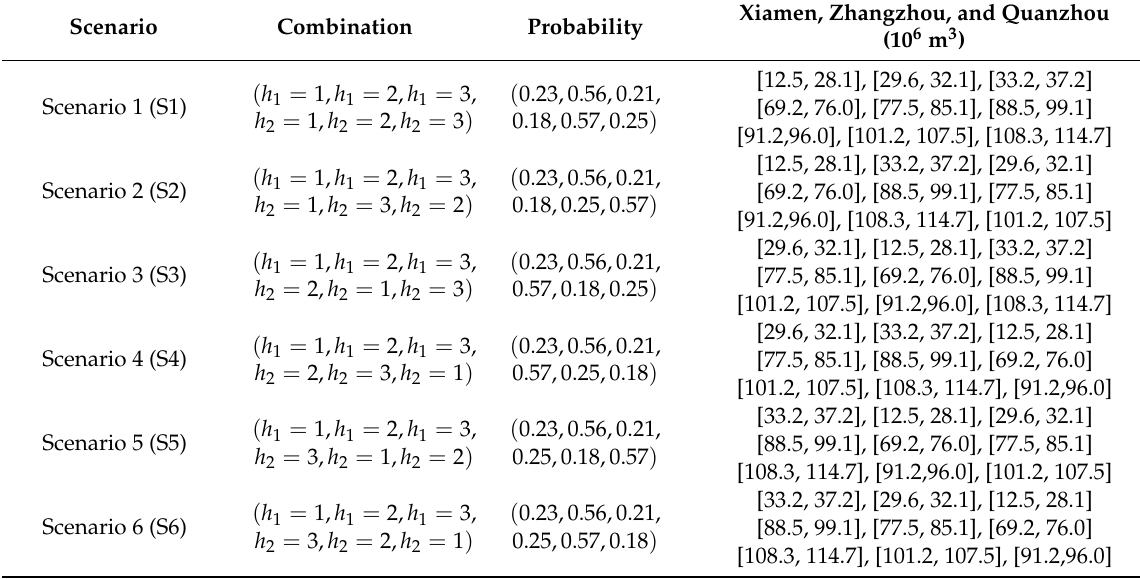
Table 3. Stochastic groundwater.